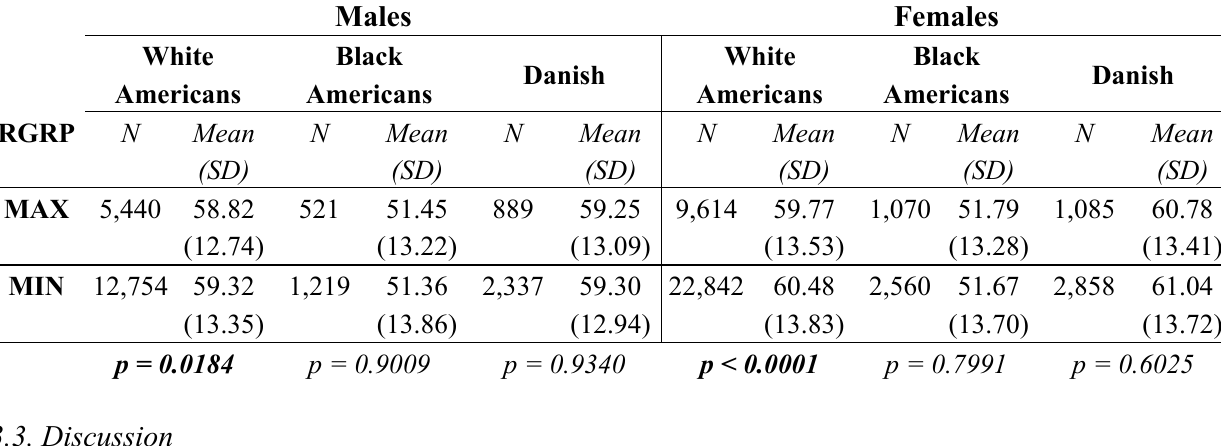
Table 5. Mean age at death for the MS cohort by sex.